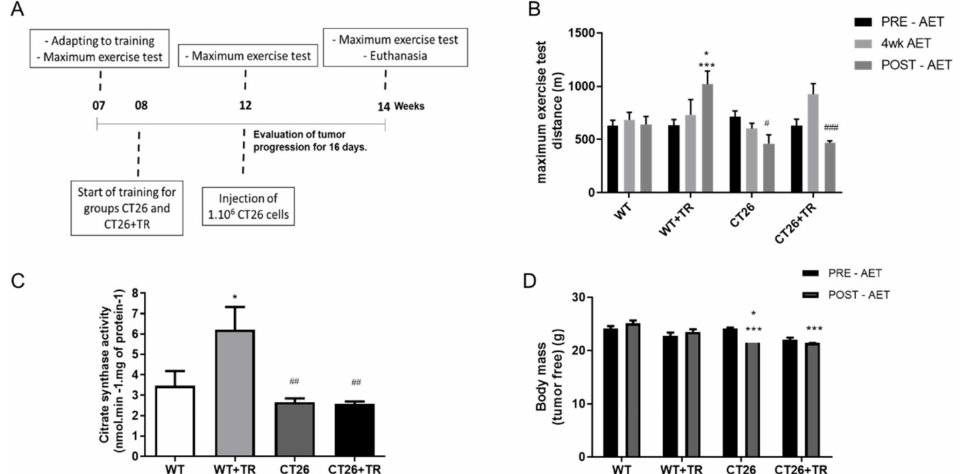
Figure 1. Experimental design, Maximum exercise test, Citrate synthase activity and Body mass to CT26 cachectic mice. ( A ) Experimental design; Groups: WT—wild type sedentary; WT+TR—wild type trained; CT26—colon cancer sedentary; CT26+TR—colon cancer trained. ( B ) Maximal distance running in the maximal exercise test before aerobic exercise training protocol (PRE-AET), four weeks of aerobic exercise training protocol (4wk-AET) and after the end of aerobic exercise training protocol (POST-AET); data are reported as means ± SEM, * p < 0.05 vs. WT+TR PRE-AET, WT+TR 4wk AET, WT POST-AET and CT26 4wk AET. *** p < 0.001 vs. CT26 POST-AET, CT26+TR POST-AET. # p <